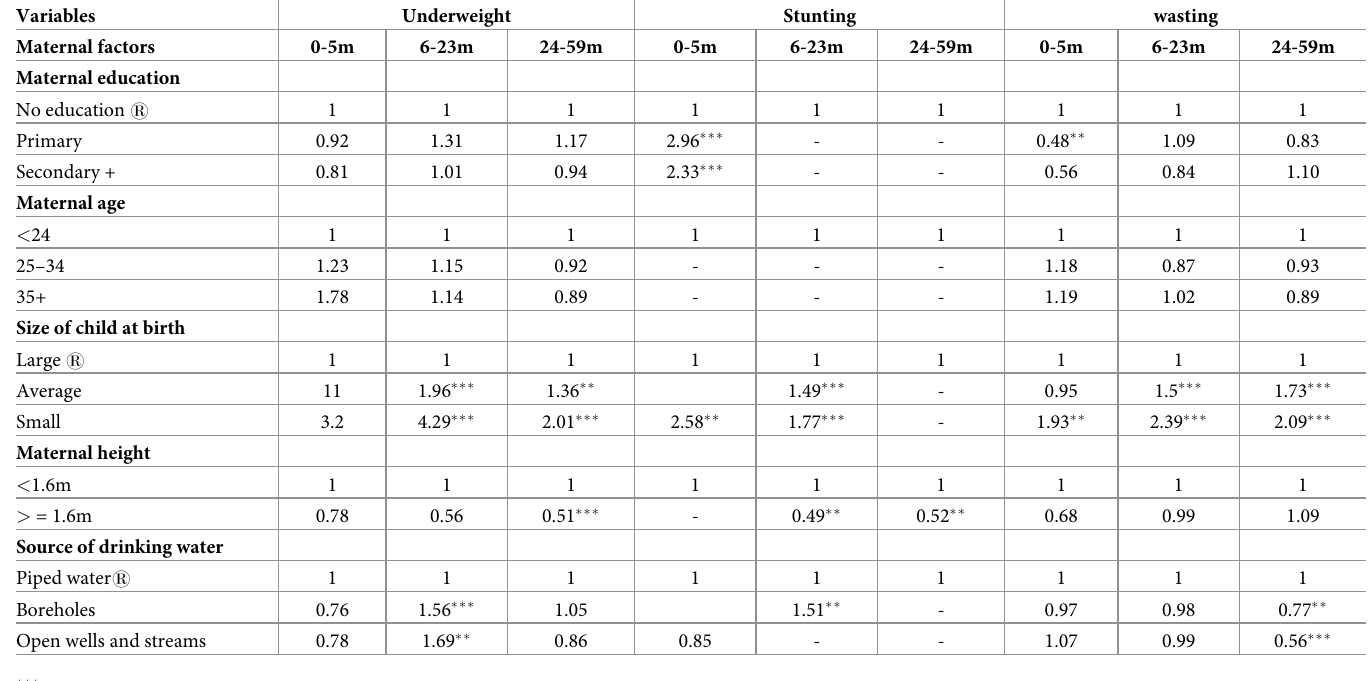
Table 5. Maternal and environment control variables estimating rural under-five children nutrition outcome by ages between 0–5, 6–23 and 24–59 months